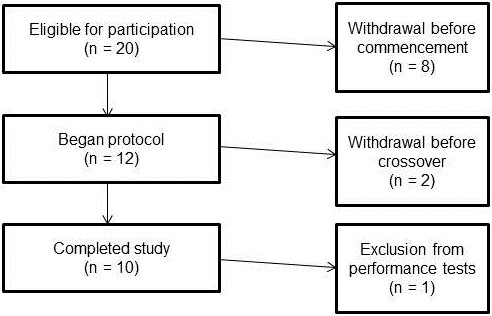
Consort diagram.